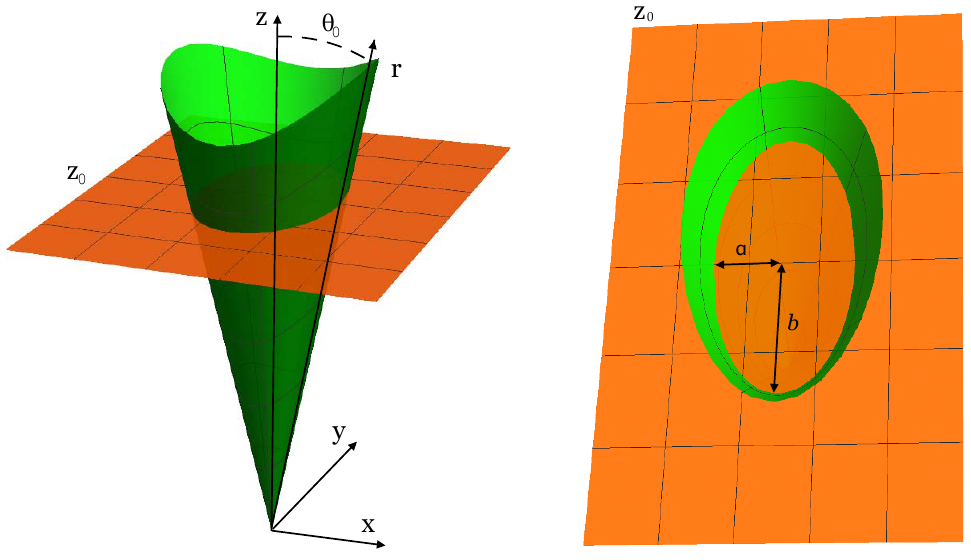
Figure 2 . We plot an elliptic cone defined by θ = θ 0 in the coordinates eq. (2.43) (left). The intersection of constant height planes z = z 0 with the cone form ellipses of semi-minor and semi- major axis a (the direction along which θ 0 is defined) and b , respectively